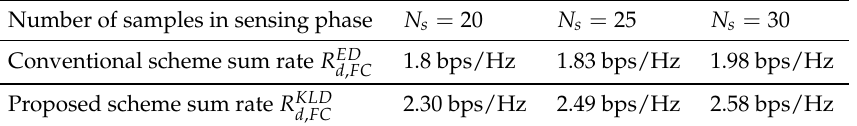
= p KLD = f , FC f , FC